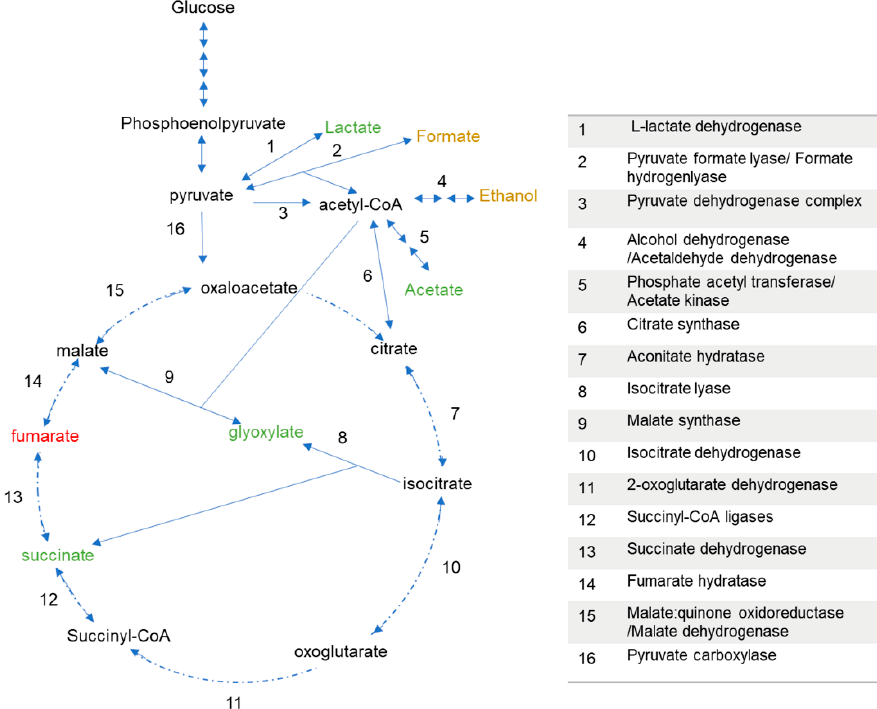
Figure 6. Glucose metabolism pathway and putative enzymes predicted/or shown to occur in P. thermoglucosidasius [26,27]. Green (detected above 0.1 g/L), orange (detected below 0.1 g/L) and red (not detected) fonts indicate substances analysed in the current work and black fonts indicate substance not analysed. Multiple arrows show pathways with two or more reactions.